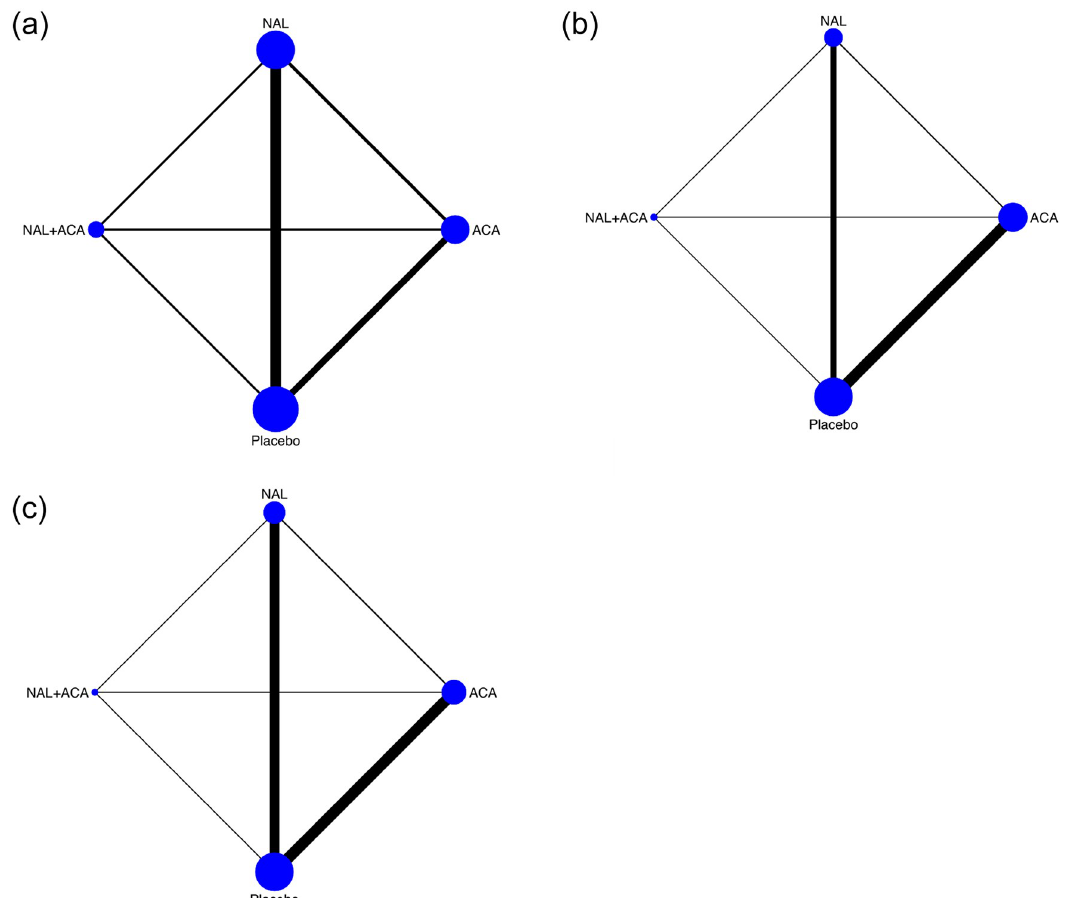
Fig 4. Alcohol dependence: The network structure. The figure shows the network structure: A: Return to Heavy Drinking, B: Return to Drinking and C: Discontinuation. The thicker the lines the higher the number of studies reporting results on the considered outcome.